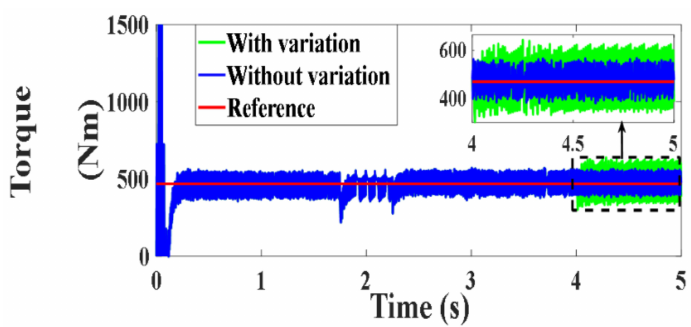
Figure 105. Developed torque under PVC (Nm).